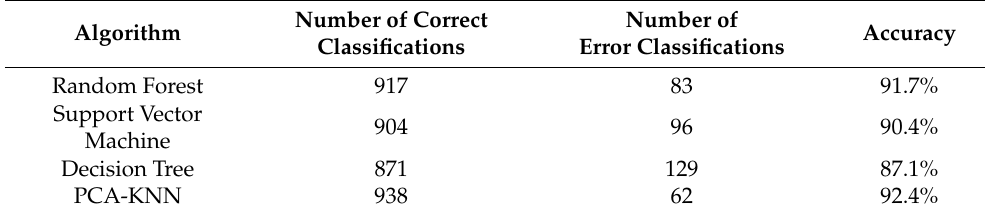
Table 4. Comparison of classification accuracy of different